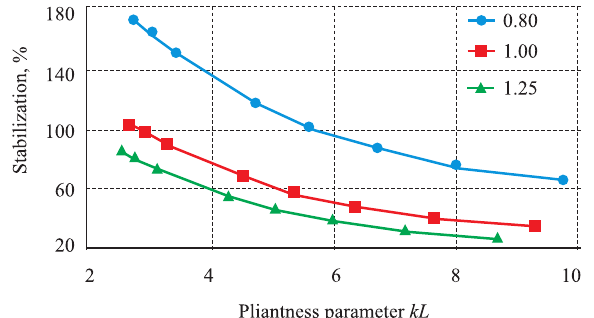
Fig. 6. Stabilization of general displacements, at the middle of the second span, by the bending stiffness